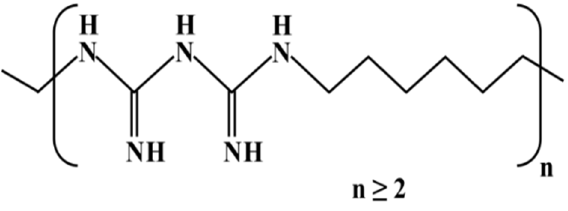
Figure 2. Chemical structure of poly(hexamethylene biguanide).